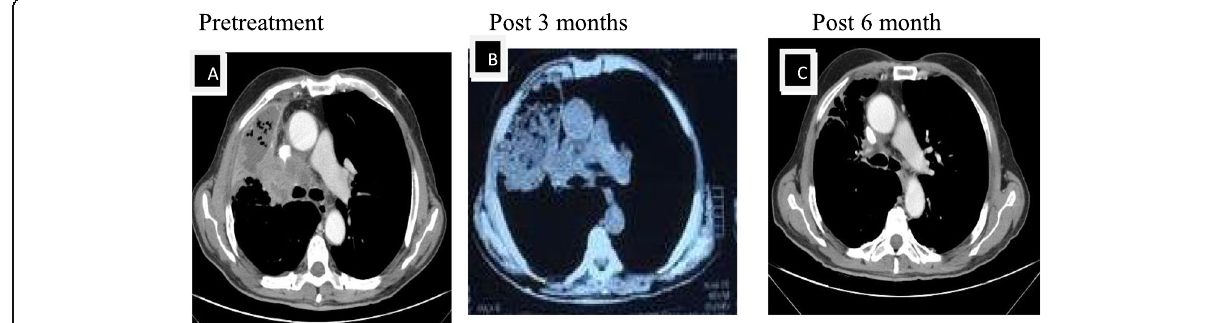
Fig. 2 Male patient 44 years, non-smoker, diagnosed as adenocarcinoma. CT showed right upper lobe mass ( a before treatment, b post 3 months